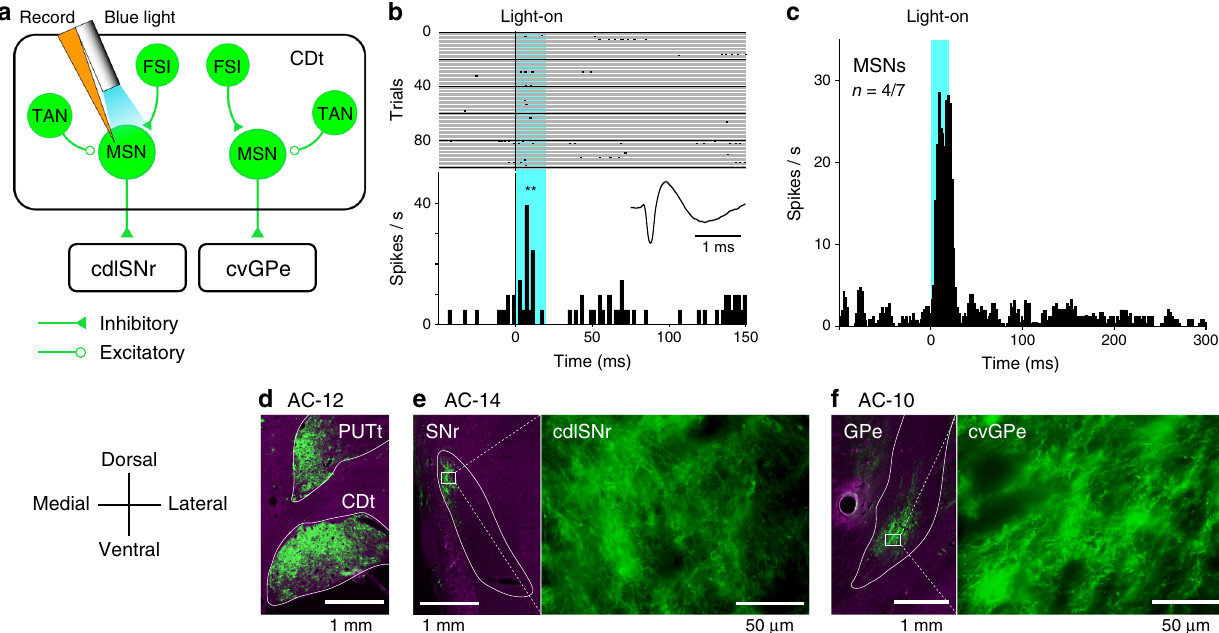
Fig. 2 Optically evoked responses and ChR2-expressing CDt axon terminals in SNr and GPe. a Recording from CDt neurons during optical stimulation in CDt. MSNs in CDt receive inhibitory inputs from FSIs and excitatory inputs from TANs, and have projections to cdlSNr or cvGPe. The ChR2 vector was non-selectively transfected in all groups of CDt neurons. b A representative MSN showing an excitatory response to optical stimulation (20 ms duration) ( P = 0.0062, Wilcoxon singed-rank test, two-sided). Raster plots show the activity aligned to the stimulation onset. PSTHs show the average response of the neuron to the stimulation across trials. Light-blue shade indicates the stimulation period (0 – 20 ms). An inset shows the MSN ’ s spike waveform. **indicates P < 0.01. c The average activity of four out of seven MSNs showing signi fi cant excitatory responses to the optical stimulation ( P < 0.05, Wilcoxon singed-rank test, two-sided). d ChR2-positive neurons in CDt and PUTt of monkey SH. Green signal indicates enhanced EYFP signal. Scale bar: 1 mm. Histological results of monkey ZB replicated the ChR2-positive neurons in CDt and PUTt. e Left: ChR2-positive axon terminals in cdlSNr of monkey SH. Scale bar: 1 mm. Right: enlarged image of the axons in cdlSNr (the area shown by white box in left). Scale bar: 50 μ m. The results of monkey ZB replicated the ChR2-positive axon terminals in cdlSNr. f Left: ChR2-positive axon terminals in cvGPe of monkey SH. Right: enlarged image of the axons in cvGPe (the area shown by white box in left). Scale bar: 50 μ m. The results of monkey ZB replicated the ChR2-positive axon terminals in